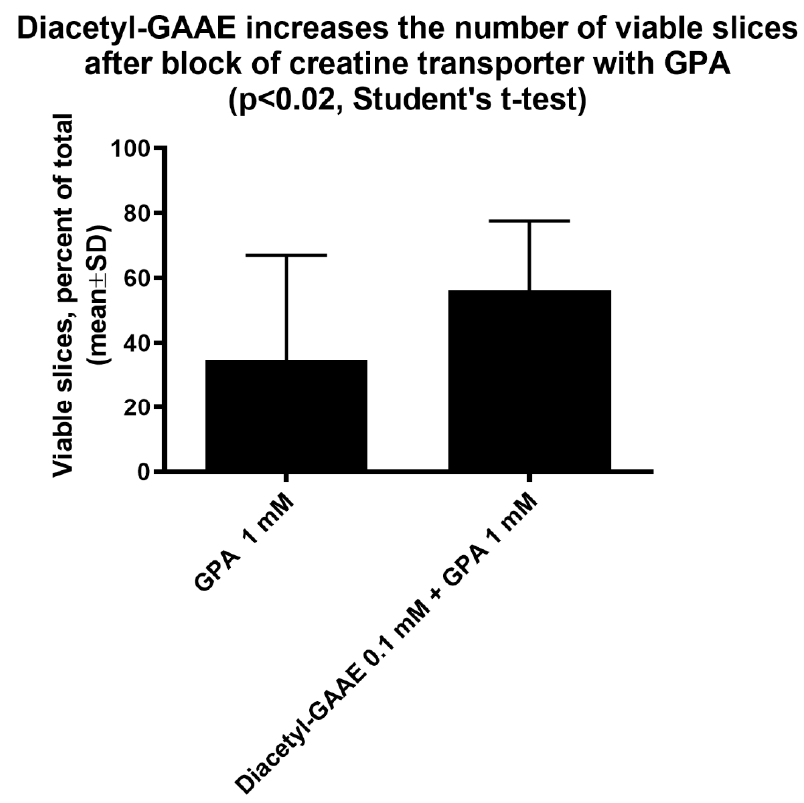
Figure 10. Slices were incubated with the creatine transporter block guanidine acetic acid (GPA). As expected, this treatment reduced drastically the percent of slices that in each batch maintained syn- aptic transmission (“viable” slices—note that control slices have a viability close to 100%, not shown). Co-incubation with Diacetyl-GAAE reduced this damage in a statistically significant way. Control slices were incubated with GPA 1 mM only, Diacetyl-GAA slices were incubated with